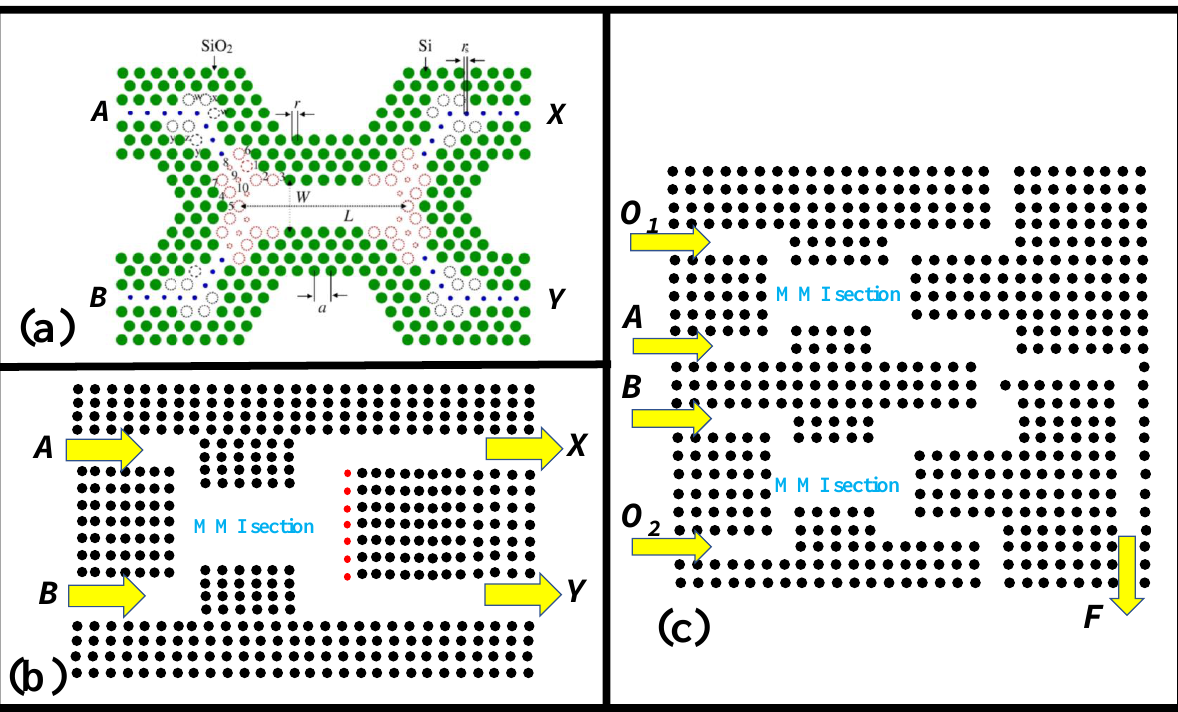
Figure 7. Schematic of OLGs established on MMI. Inspired by [146], ( a ) AND/XOR OLG, ( b ) XOR/XNOR, ( c ) AND and NOR OLGs. Inspired by [150].